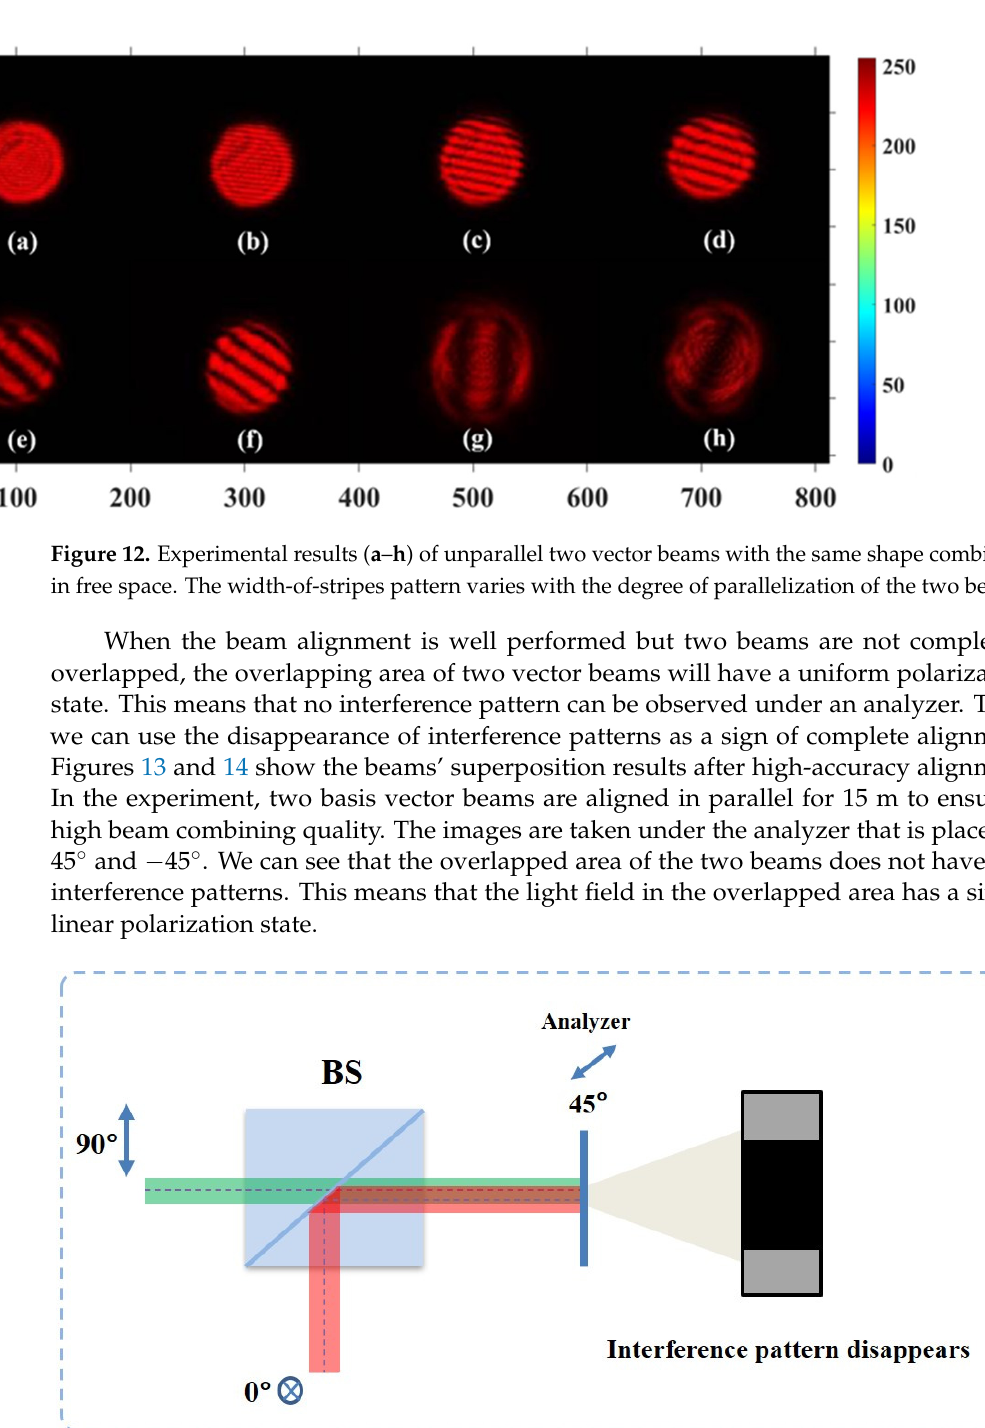
Figure 14. The two orthogonal vector beams are completely aligned. The superposition area of two beams has a single polarization state. ( a ) is the result when the polarizer is placed at 45°, ( b ) is the result when the polarizer is placed at –45°, and ( c ) is the polarization state of the combined beams. As shown in Figure 14, when two orthogonal vector beams are successfully combined into one single vector beam, the amplitude and polarization angle of the output beam can be determined by two factors, respectively: the absolute amplitude of two input beams and their amplitude ratio. In this experiment, two input vector beams have the same am- plitude and the overlapped area after beam combining has a polarization angle of 45°. As shown in Figure 15, when the analyzer is set at 45°, the intensity of the superposition area is about 2√2 times compared with the intensity of input beams (not overlapped part). This result is further proof that the superposition of two vector beams in the overlapped area is achieved. By completely overlapping the two vector beams, the final superposition process of the two vectors can then be completed. In summary, this experimental result indicates that two vector beams can be directly combined into one single beam in free space using a beam combiner. In addition, a precise alignment calibration in the order of a wavelength is necessary. This means that two vec- tor beams with independent amplitude information and the same holographic infor- mation can be combined into one single light field. Therefore, the polarization angle of the output light field can be actively modulated without the loss of holographic information. This ensures the feasibility of the phase and polarization method in use for data writing light field generation.